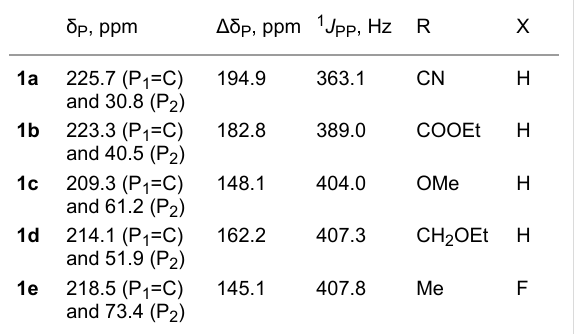
Table 1: 31 Р { 1 H} NMR spectral data of new 1-R-1,2-diphospholes 1a–e